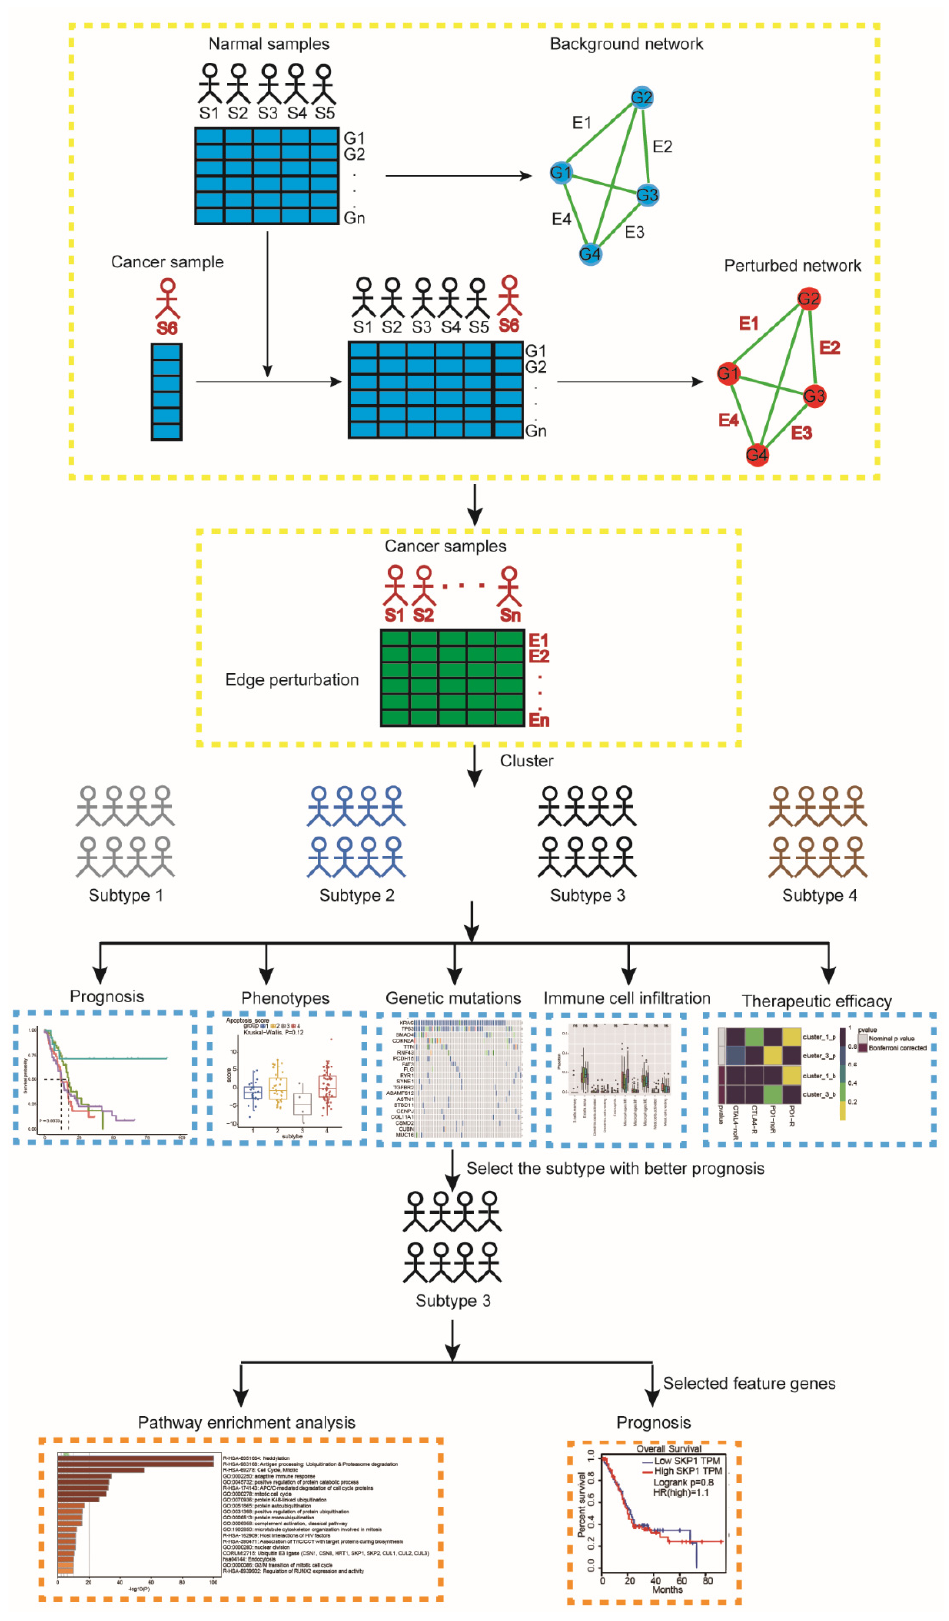
Figure 1. A flowchart identifying pancreatic cancer subtypes. For a group of normal samples, a reference background network can be constructed by the correlations between genes based on expression data of this group of samples. A new cancer sample S6 is added to the group, and the perturbed